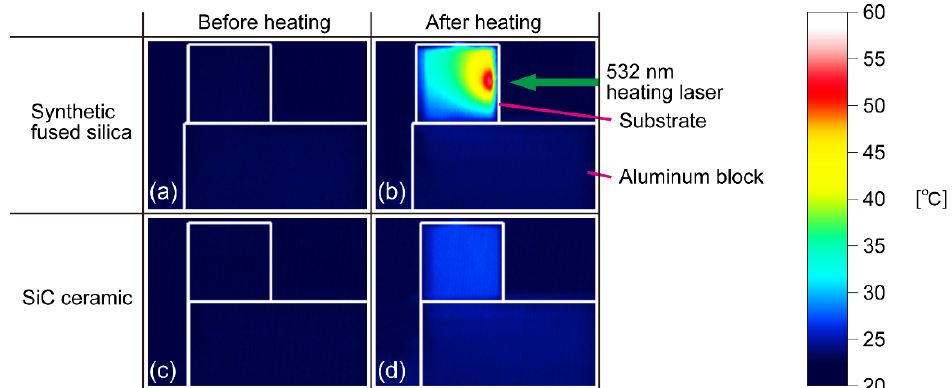
Figure 4. Temperature distributions of substrates placed on the aluminum block are measured from the lateral side with a thermography camera. Temperature distributions of the synthetic fused silica substrate ( a ) before laser irradiation and ( b ) after 20 min laser irradiation. Temperature distributions of the SiC ceramic substrate ( c ) before laser irradiation and ( d ) after 20 min laser irradiation. White lines show the border of the substrate and the aluminum block as a visual guide. The peak temperatures in (b) and (d) are ~54 and ~26 °C, respectively.